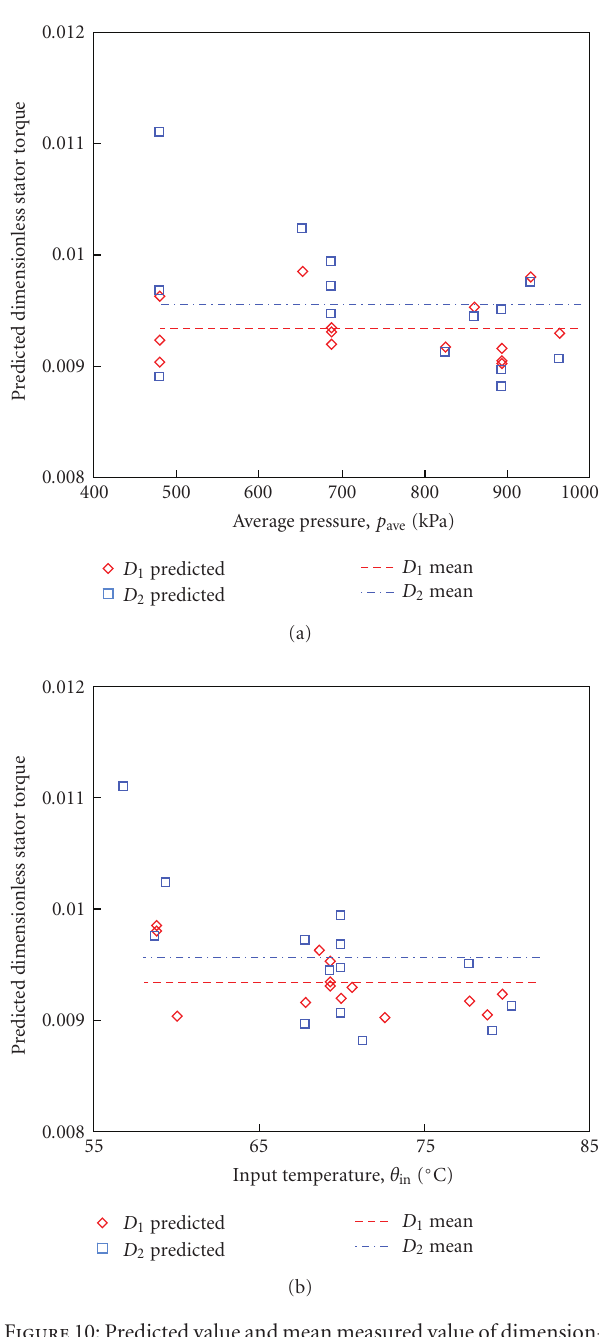
Figure 10: Predicted value and mean measured value of dimension- less stator torque as (a) a function of average pressure and (b) input temperature from PP